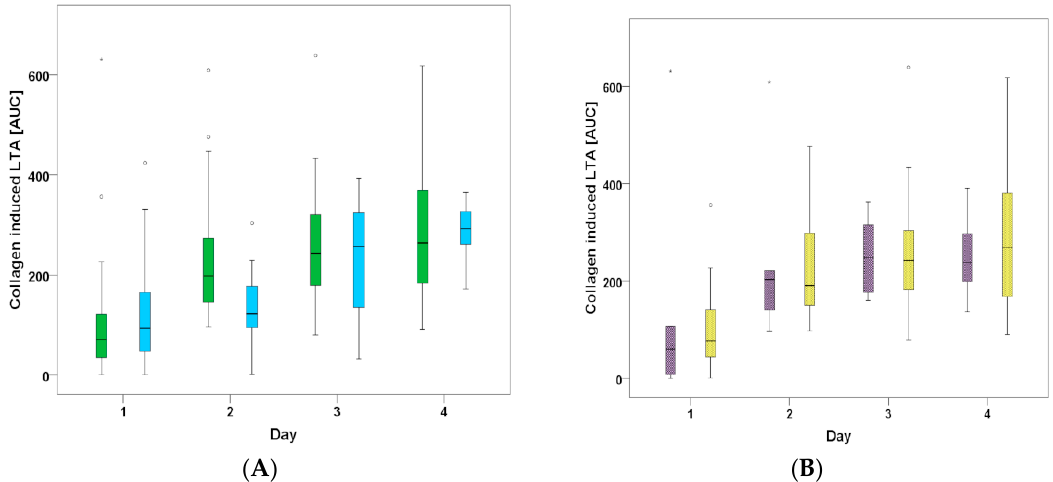
Figure 2. ( A ) Median collagen AUC for the first 4 days. CANGRELOR (green) vs. ORAL-P2Y12 (blue). ( B ) Median collagen AUC for the 25 patients of the CANGRELOR group. Patients with intravenous ASS therapy (black) or oral therapy (gray) after day 1.